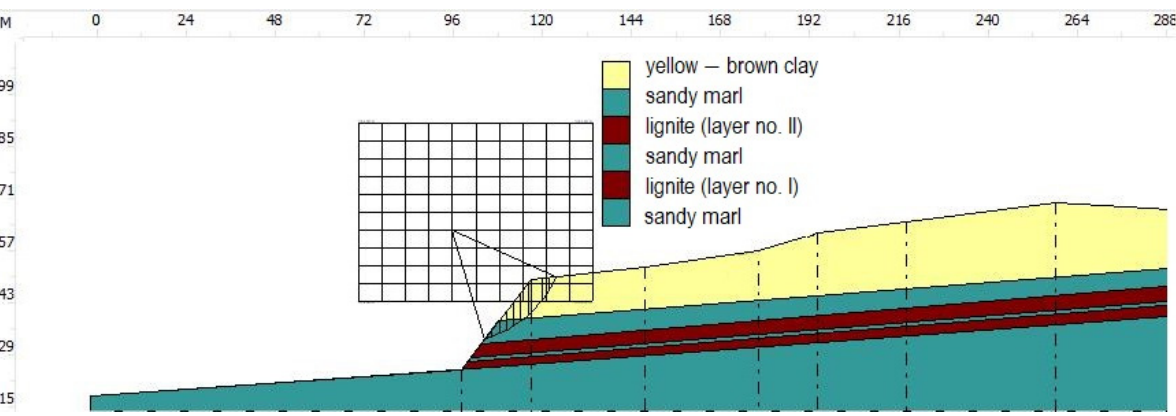
Figure 11. Section L1–Stability analysis for the proposed design.